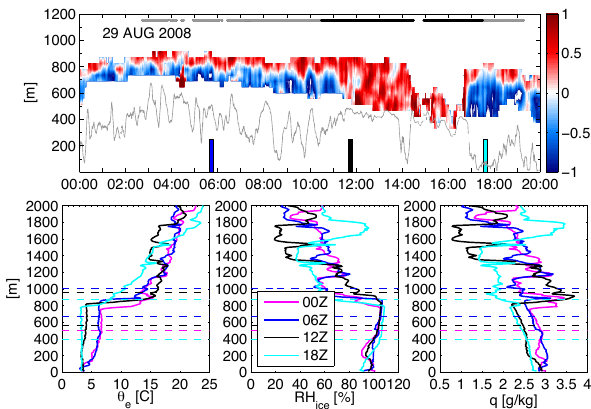
Figure 8. Same as in Fig. 6, but for the period 00:00-20:00 UTC on 29 August. The Fig. 8. Same as in Fig. 6 but for the period 00:00–20:00 UTC on 00:00 UTC radiosounding was released just prior to the start of this period, and its 29 August. The 00:00UTC radiosounding was released just prior to the start of this period, and its release time is not indicated by a release time is not indicated by a magenta bar in the upper panel. Times when an magenta bar in the upper panel. Times when an upper-level cloud upper-level cloud above 5 km is present is indicated by the dots in the upper panel; above 5km are present is indicated by the dots in the upper panel; gray dots indicate times when upper cloud radar signatures are suggestive of ice-only gray dots indicate times when upper cloud radar signatures are sug- hydrometeors, while black dots represent times when liquid hydrometeor signatures gestive of ice-only hydrometeors, while black dots represent times are observed in the upper cloud radar profiles. when liquid hydrometeor signatures are observed in the upper cloud radar